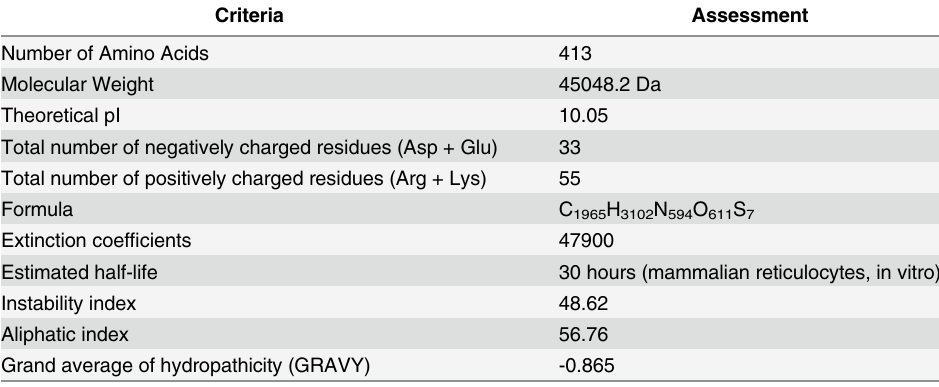
Table 1. Secondary structural characteristics of the highest antigenic N protein (Genbank ID: AGV08499.1) of